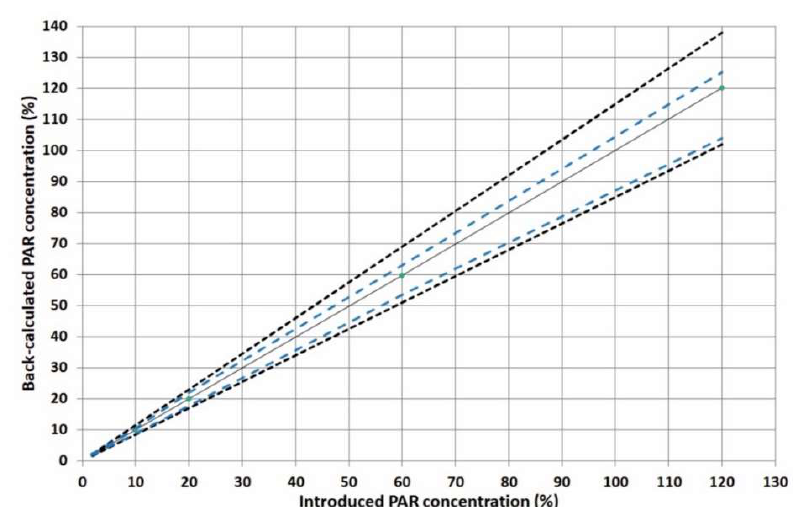
Figure 4. Linearity profile for PAR. The identity line (Y = X) corresponds to the plain blank line, the accuracy profile (β-ΕΤΙ) corresponds to the blue dashed line, and the acceptance limits λ ±15% correspond to the dotted curves.